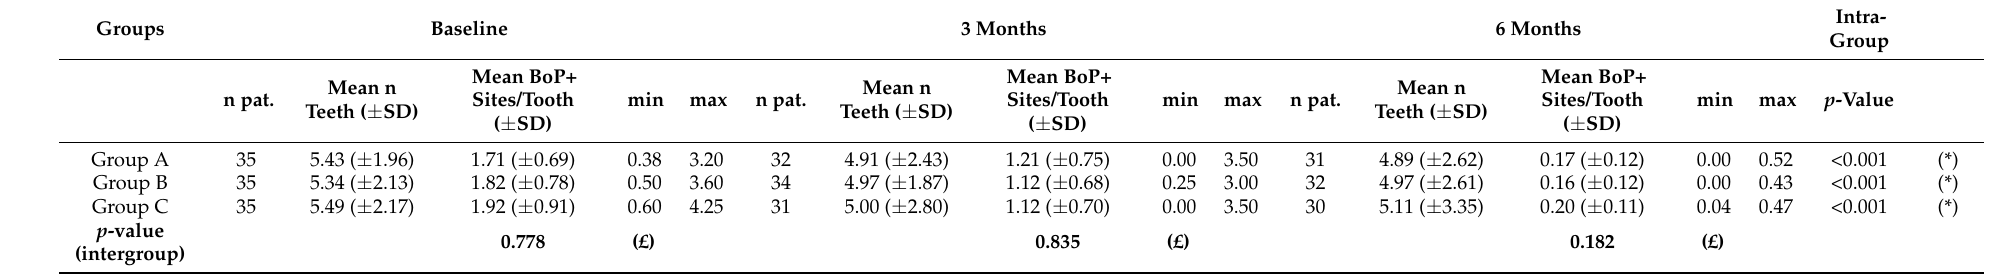
Table 3. Mean number of BOP+ sites ± standard deviation (SD) per tooth (six-point measurement) in the three treatment groups (A: PDT, B: LDDs, C: control) at baseline and after 3 and 6 months.